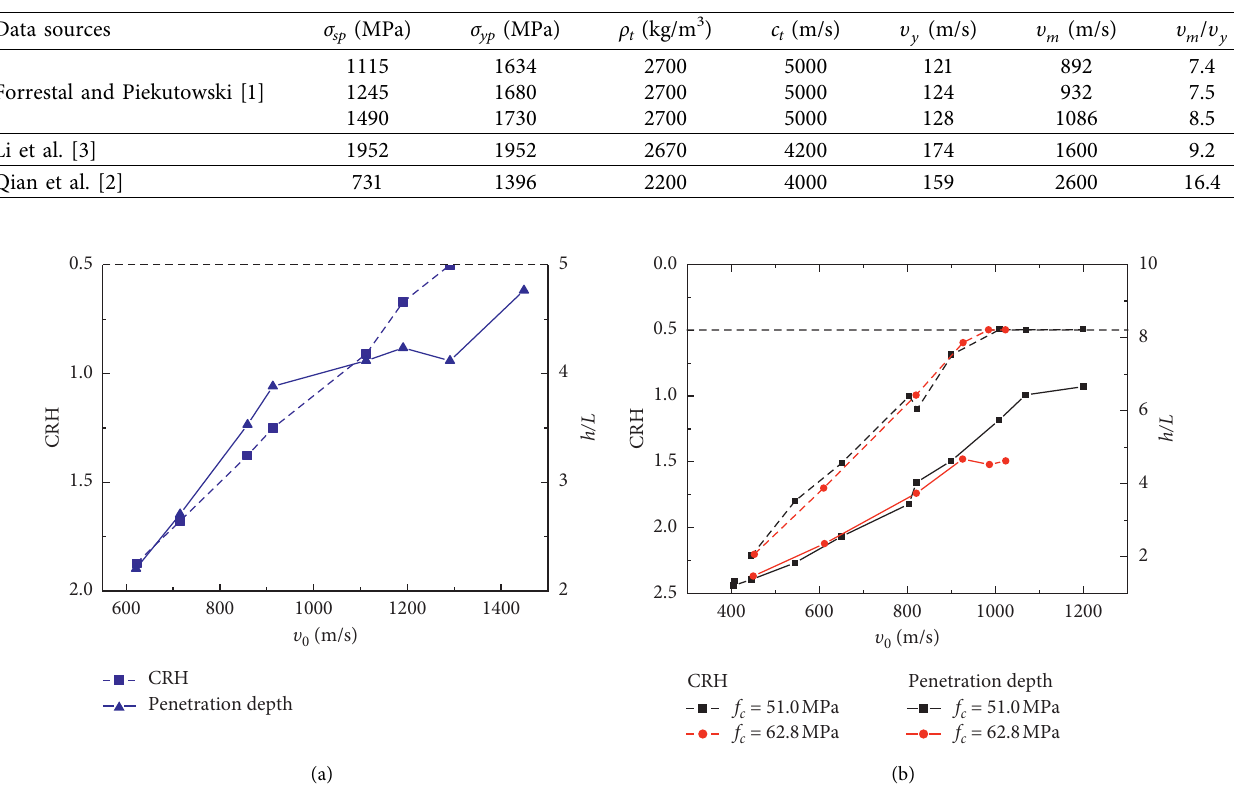
Table 1: Parameters of projectiles and targets in different penetration tests.